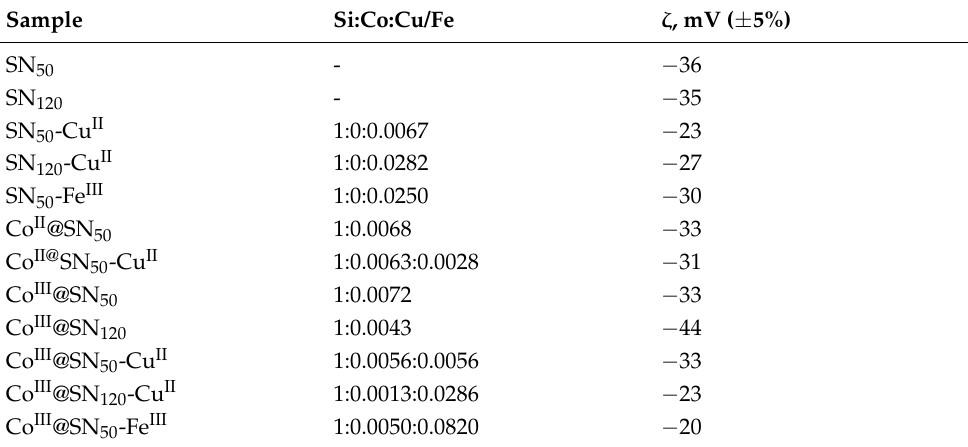
Table 1. Si:Co:Cu or Si:Co:Fe Molar ratio by ICP-OES technique and ζ -potential values evaluated